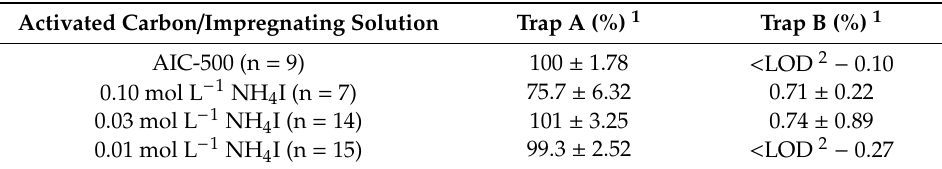
Table 1. Performance of commercially available and in-house prepared activated carbon traps. All results refer to 1000 ng of purged / spiked